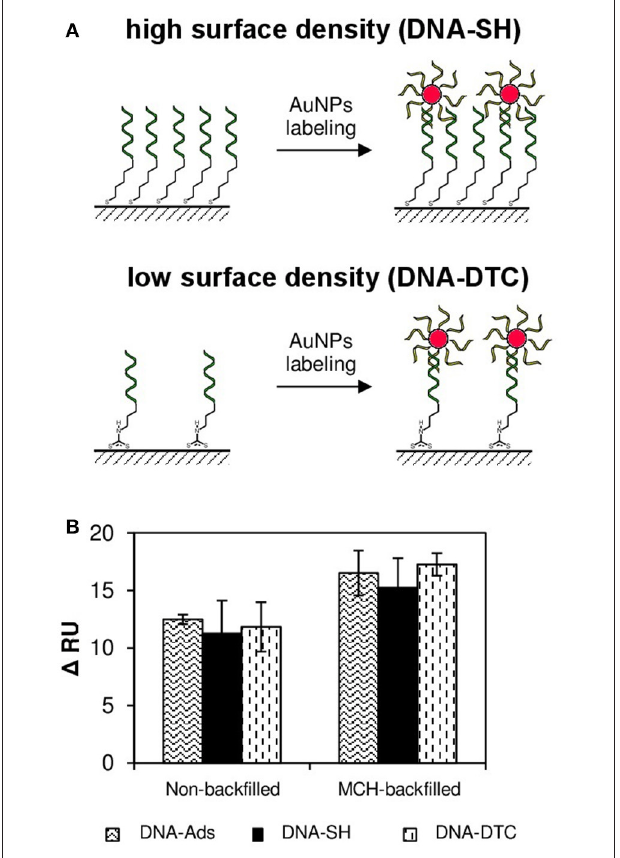
FIGURE 4 | Effect of SPRi signal amplification by means of AuNPs@ssDNA labels. SPR response showing the kinetics of interaction between the exemplary DNA receptor layer (DNA-SH) and the complementary sequence (dashed line) and AuNPs functionalized with complementary sequence (solid line). Insert outlines the differential image captured by CCD camera, showing the surface topography of the SPR sensor and illustrating the performance of AuNPs-induced SPR signal enhancement.